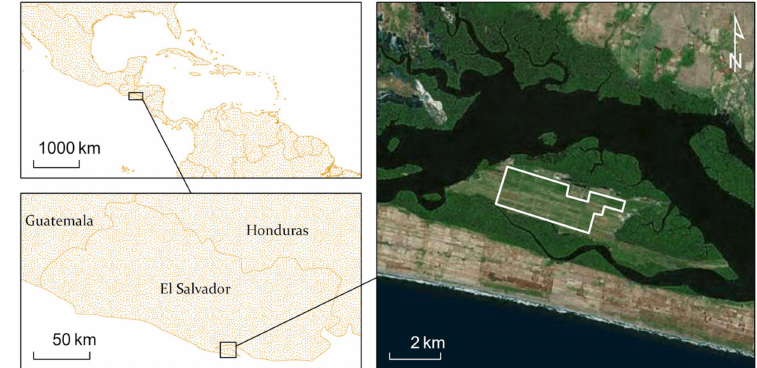
Figure 7. Coconut palm plantation in El Salvador along the Pacific Ocean shown in a true color Google Earth image. The area outlined in white was selected for data retrieval from Google Earth